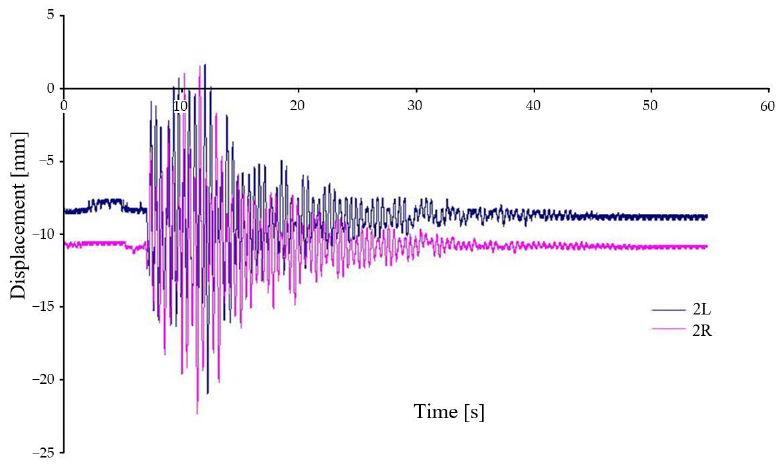
Figure 13. Relative displacement between car body and chassis frame—variant A-IV.